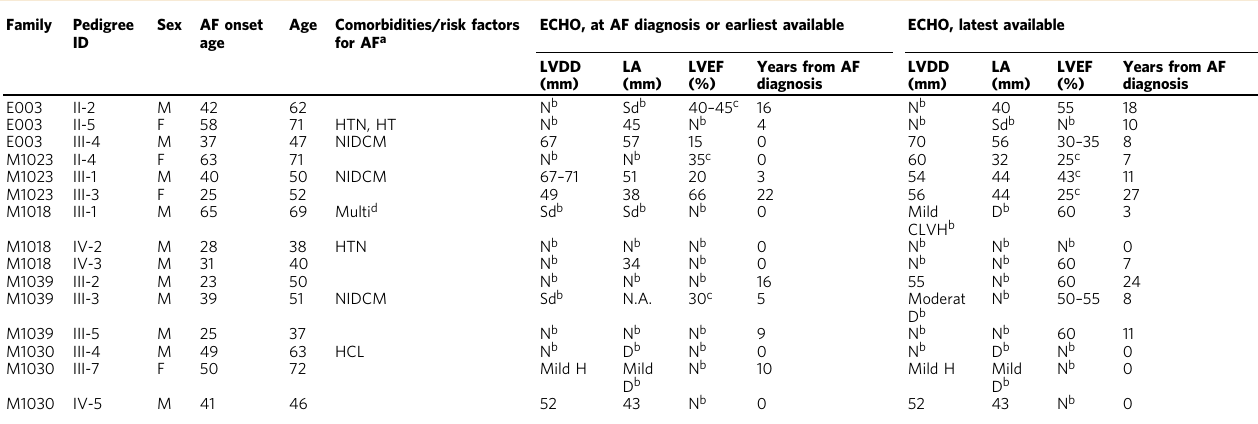
Table 3 Clinical information on the TTNtv and DSC2 loss-of-function carriers in the AF families Family Pedigree Sex AF onset Age Comorbidities/risk factors ECHO, at AF diagnosis or earliest ID age for AF a